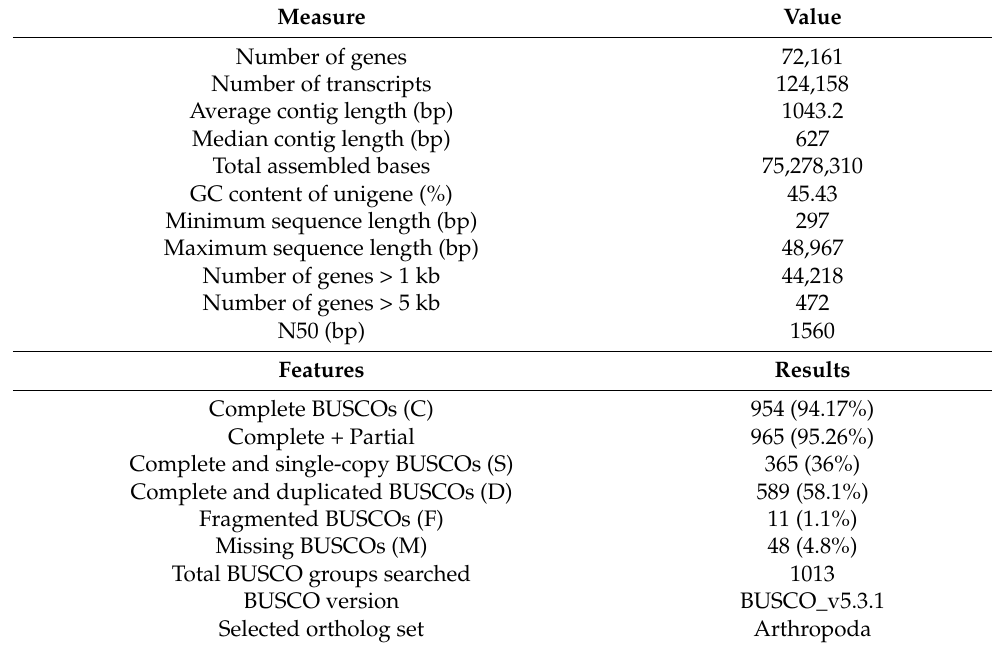
Table 1. De Novo Transcriptome Assembly statistics of P. bremeri transcripts and de novo assem- bled transcripts completeness assessment results using BUSCO analysis .